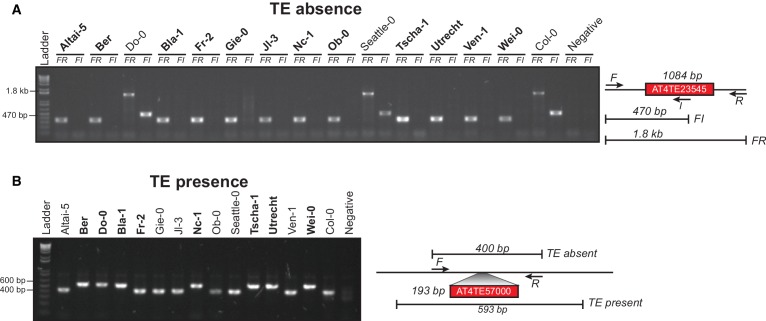
Example PCR validations for two TE variants.(A) PCR validations for a TE absence variant. Accessions that were predicted to contain a TE absence are marked in bold. Two primer sets were used; forward (F) and reverse (R) or internal (I). Accessions with a TE absence will not produce the FI band and produce a shorter FR band, with the change in size matching the size of the deleted TE. (B) PCR validations for a TE presence variant. Accessions that were predicted to contain a TE presence are marked in bold. One primer set was used, spanning the TE insertion site. A band shift of approximately 200 bp can be seen, corresponding to the size of the inserted TE.